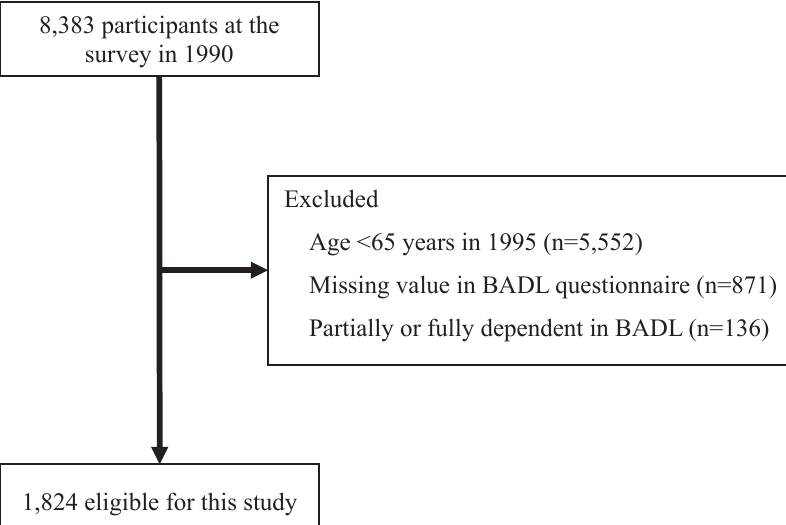
Figure 1. Flow diagram of study participants in the present analysis of the NIPPON DATA90. From 8,383 overall participants, we selected 1,824 participants after a total of 6,559 participants were excluded based on exclusion criteria. BADL, basic activities of daily